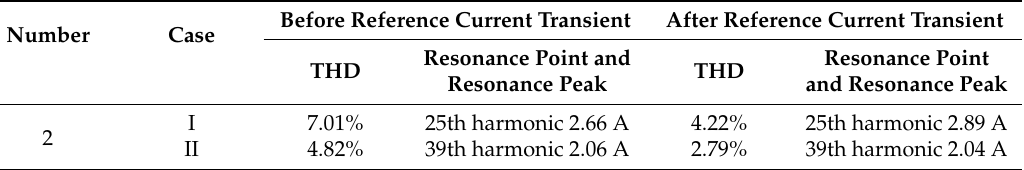
Table 5. Experimental results of the grid-connected current with two parallel inverters.